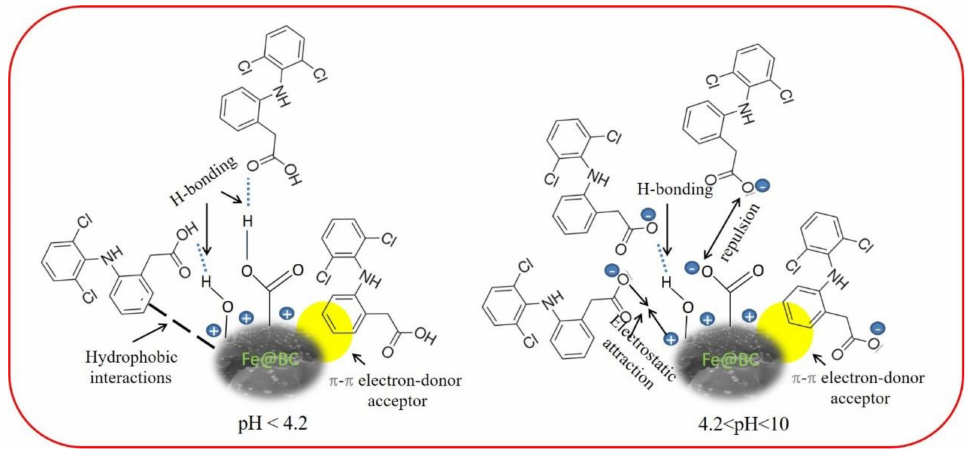
Figure 14. Proposed adsorption mechanism for DCF on Fe@BC at di ff erent pH